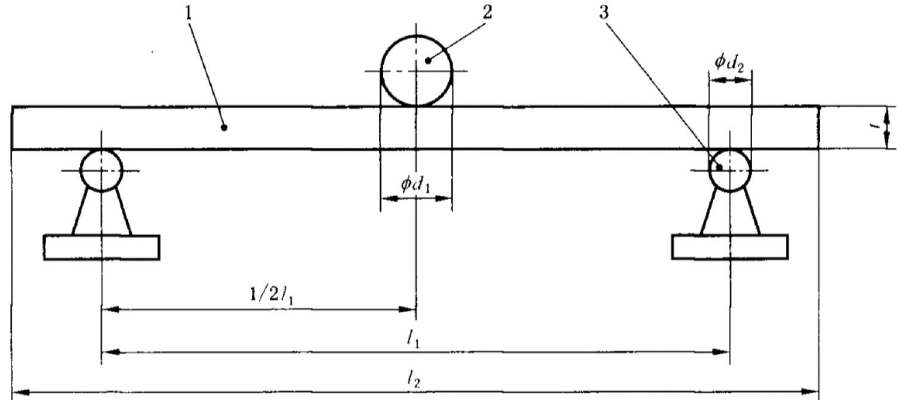
Figure 4. The flexural properties